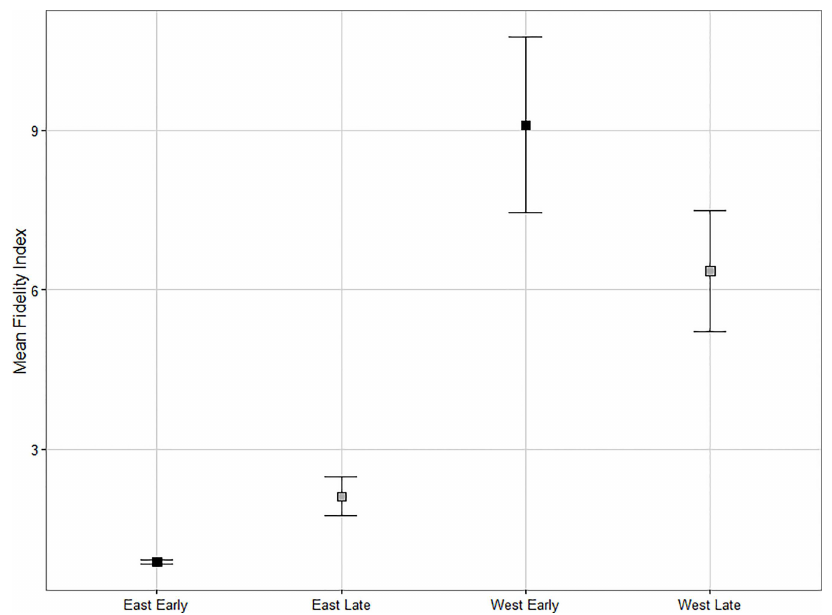
Fig 5. Mean caribou fidelity index values between time periods and study areas. A comparison of mean fidelity index values for borealcaribou ( Rangifertarandus caribou )betweenthe eastern and western study areas in the early period(black; prior to wide spread caribou habitat management policy application,1995– 2001) and late period(grey; followinghabitat management policy application,2009–2013). Error bars representstandard